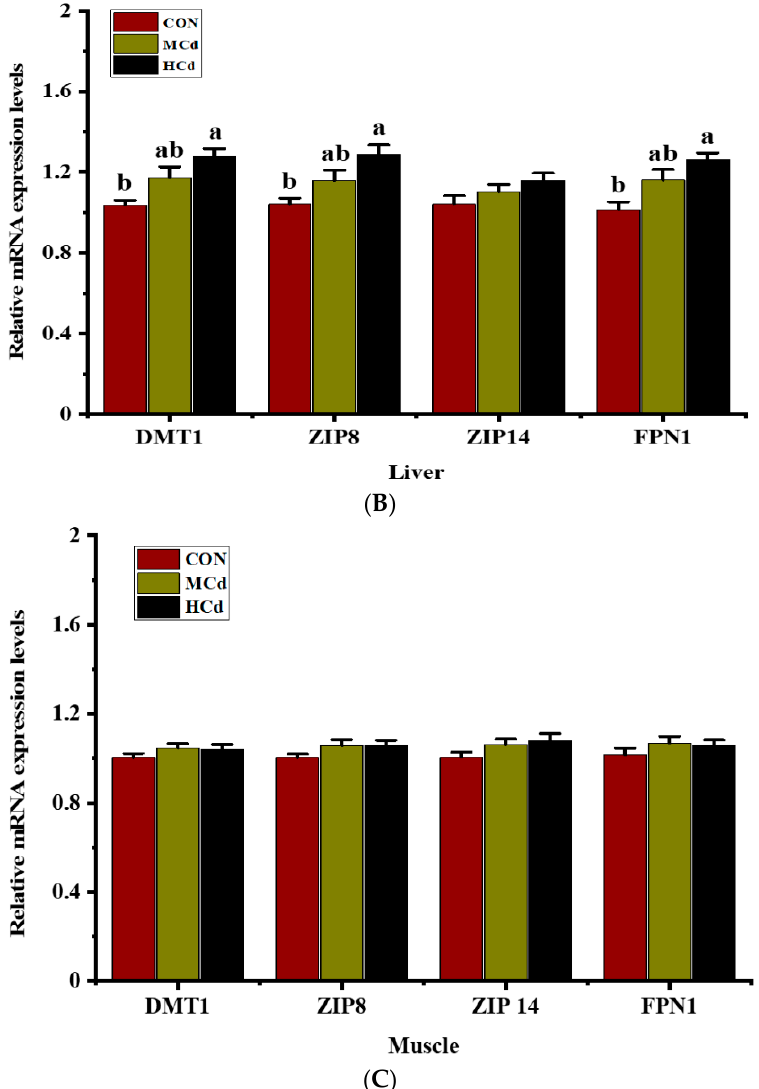
Figure 4. Effects of dietary Cd levels on the gene expressions of DMT1, ZIP8, ZIP14 and FPN1 in the ( A ) kidney, ( B ) liver, and ( C ) muscle of goats. Different letters (a, b, c) indicate significant difference a significant difference among the three dietary treatments at p < 0.05. Values are expressed as the mean ± SEM. One-way ANOVA was used, followed by post hoc Tukey’s test. ND = Not detected. Treatment: CON, MCd, HCd: 0.23, 0.63, and 1.07 mg of Cd/kg of diet DM, respectively. DMT1: divalent metal-ion transporter-1; ZIP8: Zrt-/Irt-like protein 8; ZIP14: Zrt-/Irt-like protein 14; FPN1: